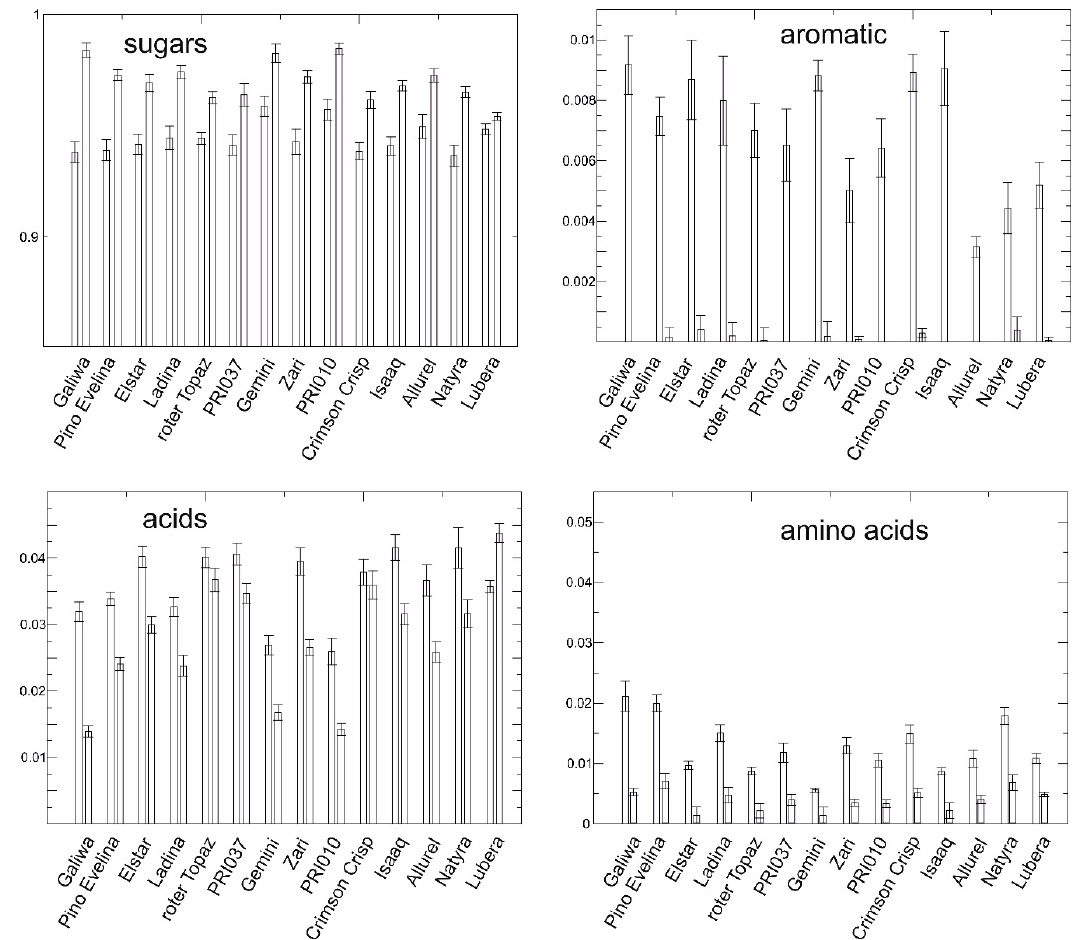
Figure 5. Relative intensities compound classes for all cultivars. Mean intensities and their standard deviation are shown for peel on the left and for pulp on the right where available.